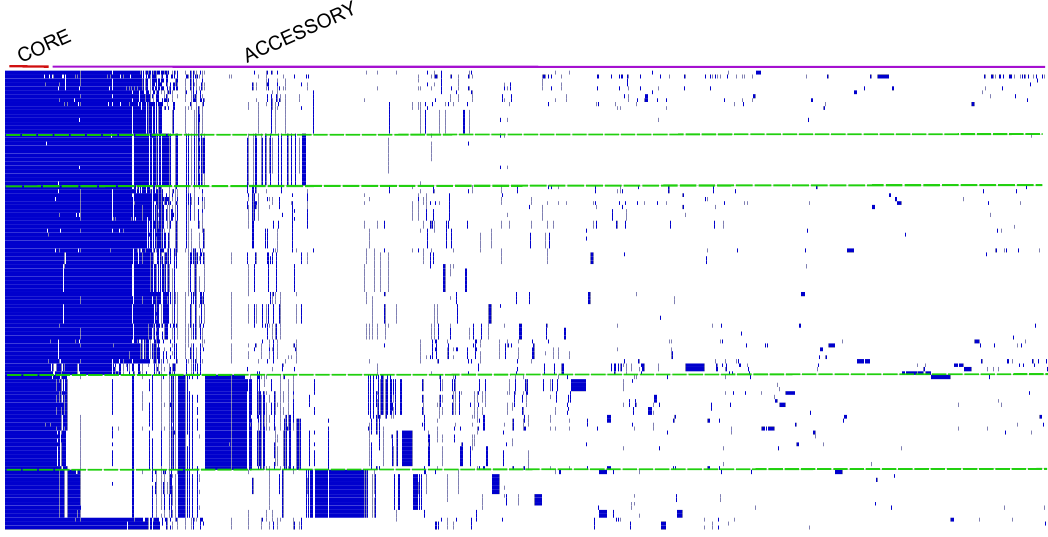
Figure 4. R. solanacearum species complex (RSSC) pangenome profile. From left to right, blue regions homogeneously distributed represent the core genome, while blue spots represent the unique genome. Blocks underneath red line make up the core genome, whilst blocks underneath purple line make up the accessory genome. From the presence–absence profile, it is possible to identify 4 major patterns in the pangenome profile, delimited by the green dotted lines.